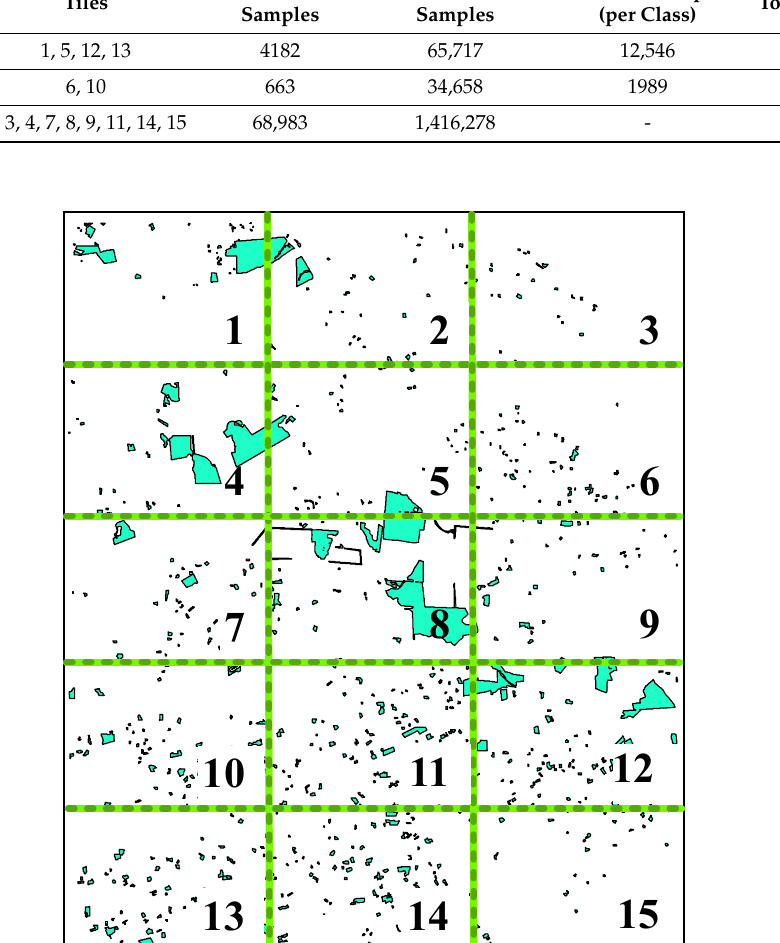
Figure 8. Distribution of the Cerrado database. The region was divided into fifteen tiles. Four tiles were used for training (1, 5, 12, 13) and two for validation (6, 10). The remaining tiles were used for